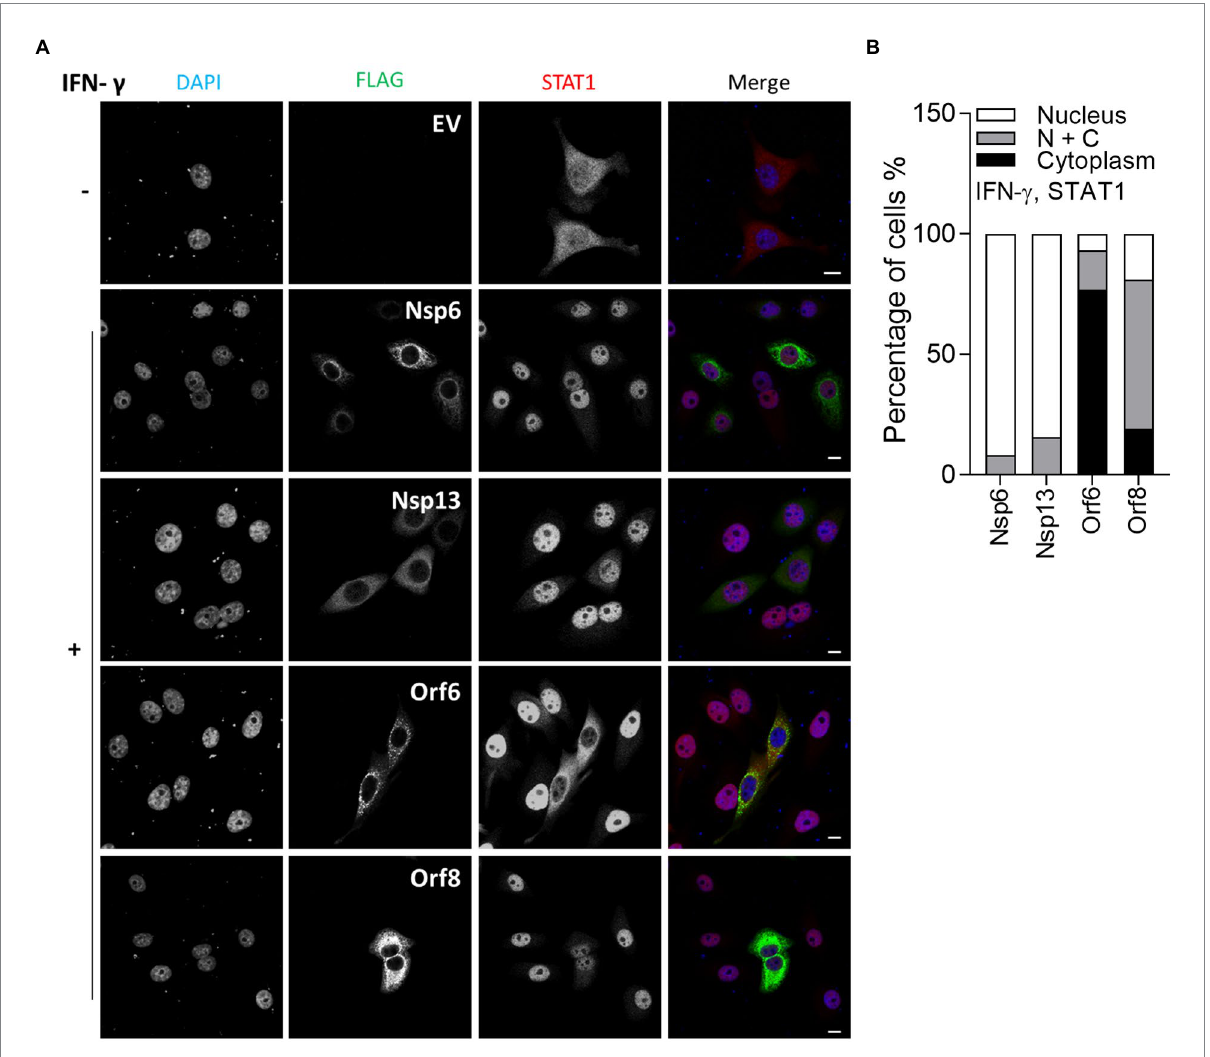
FIGURE 3 Immunofluorescence microscopy (IF) analysis of the effect of SARS-CoV-2 viral proteins on IFN- γ -induced STAT1 relocalisation. (A) As in Figure 2, except that transfected HeLa cells were stimulated with 250 ng/ml IFN- γ for 1 h and then stained for STAT1 rather than STAT2. Scale bar, 10 μ m. (B) Quantification of IFN- γ -induced STAT1 redistribution ( n ≥ 24 in each condition). N + C represents staining within both the nucleus and